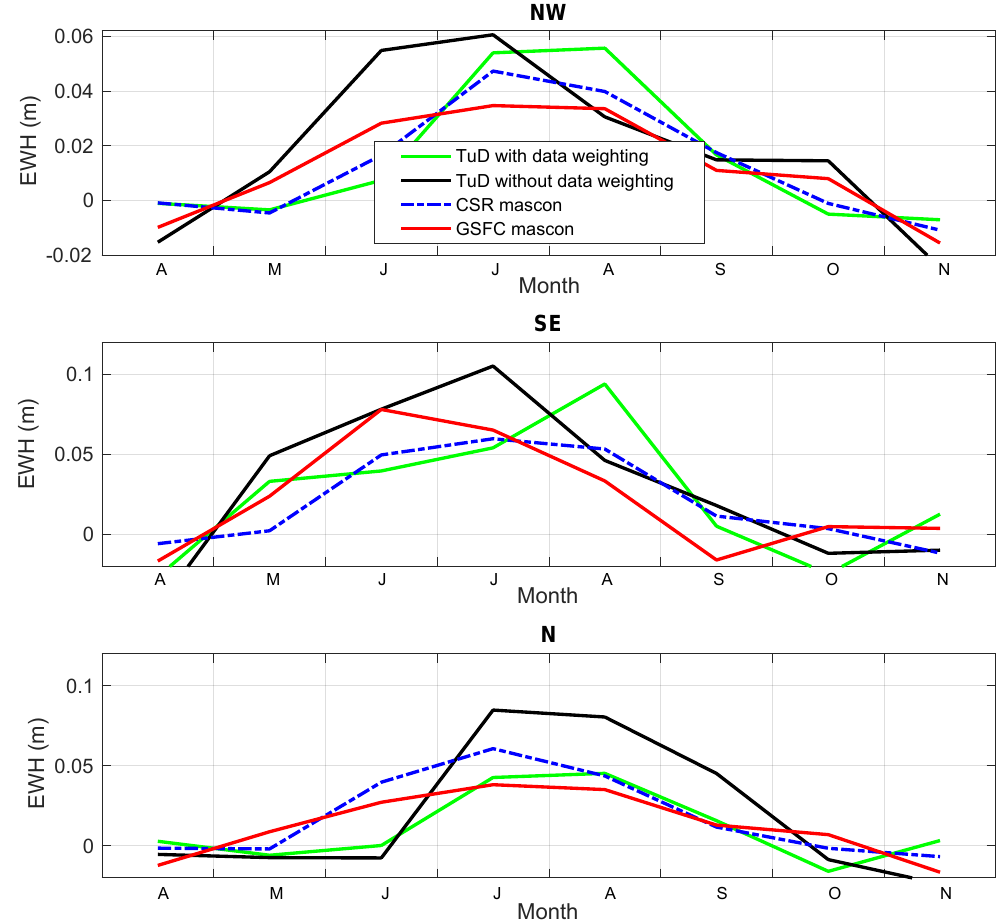
Figure A6. Similar to Fig. 9 but in meters of equivalent water height. The mean standard deviations of the errors for NW, SE, and N are 0.04, 0.07, and 0.03m, respectively.